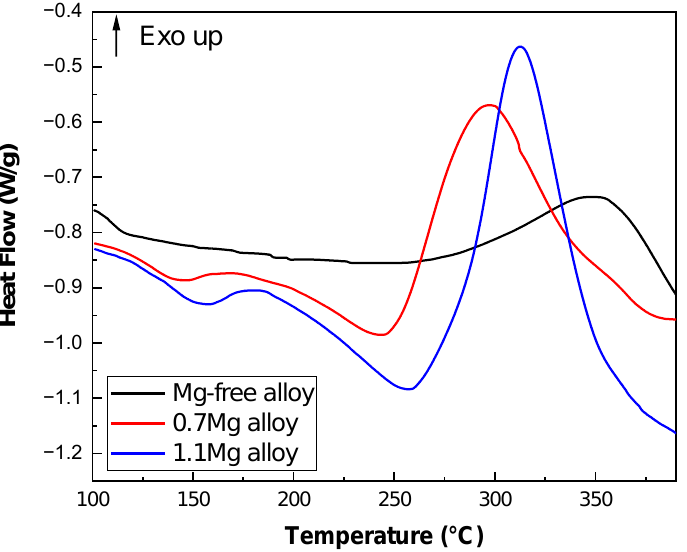
Figure 10. DSC heat flow curves of Al–Cu–Li alloys with different Mg contents.